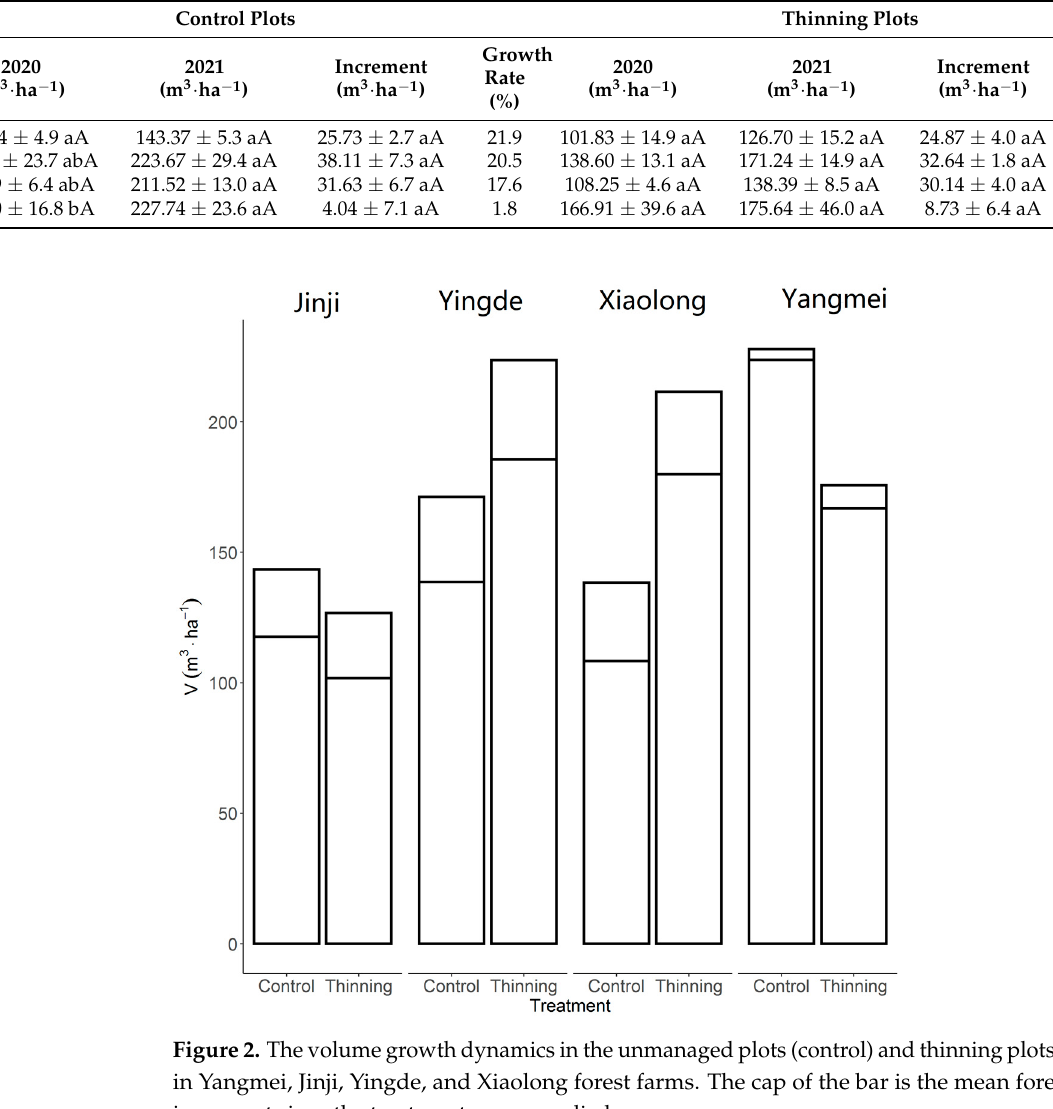
Table 3. The stand volumes (± standard errors) of different forest management in different study sites, in 2020 and 2021. Different lowercase letters indicate significant differences among different study sites in the same year and same treatment; different upper case letters indicate significant differences between different treatments in the same plots and the same year.